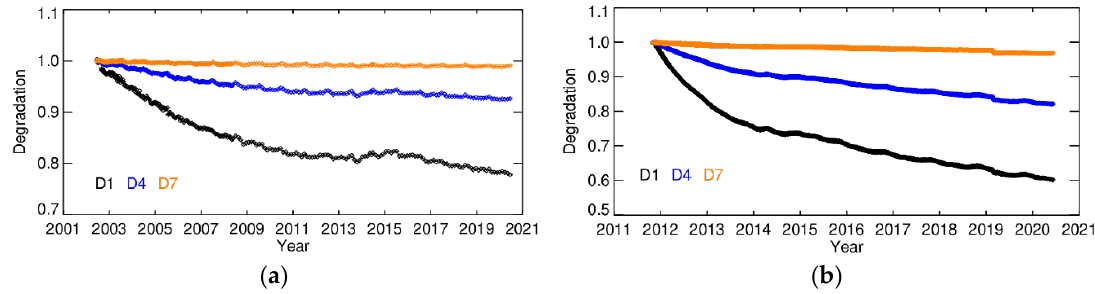
Figure 10. Aqua MODIS ( a ) and S-NPP VIIRS ( b ) SD degradation at 0.41, 0.55, and 0.86 µm.